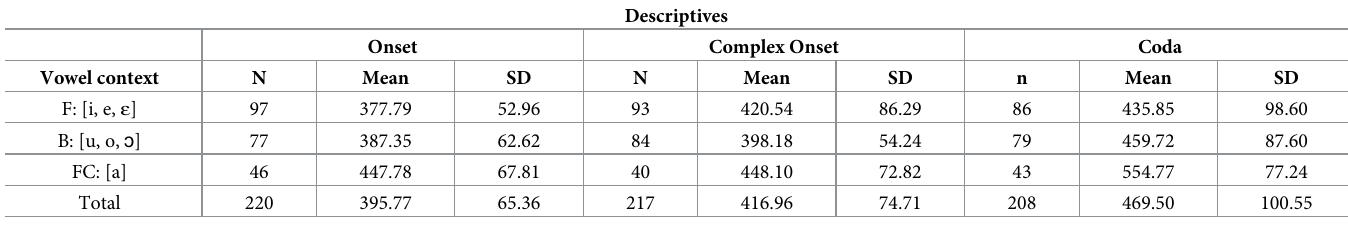
(in Hz) at the midpoint of the steady 1